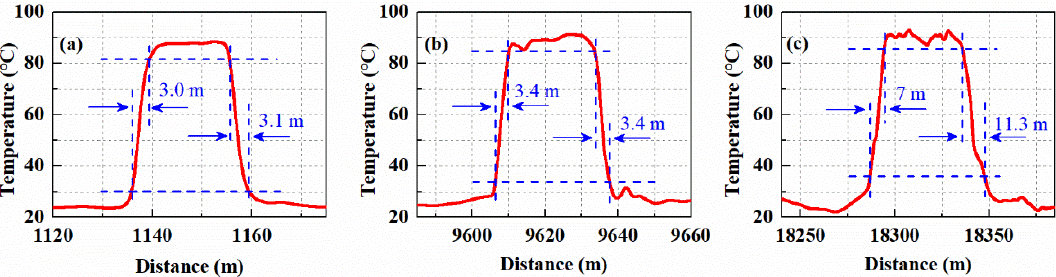
Figure 8. ( a ) Spatial resolution at 1.14 km; ( b ) Spatial resolution at 9.6 km; ( c ) Spatial resolution at 18.27 km.